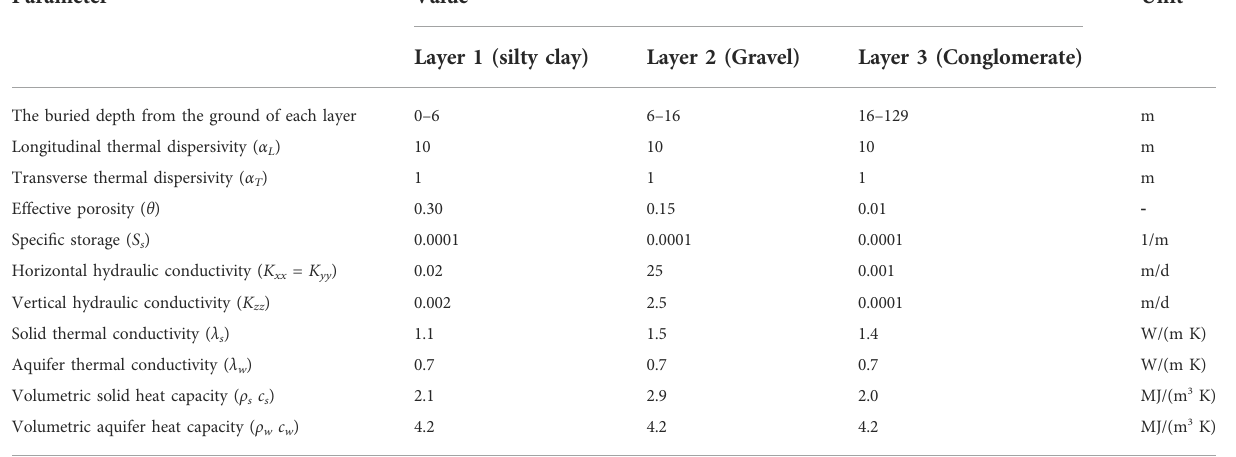
TABLE 2 Hydrogeological and physical properties implemented in the model. Parameter